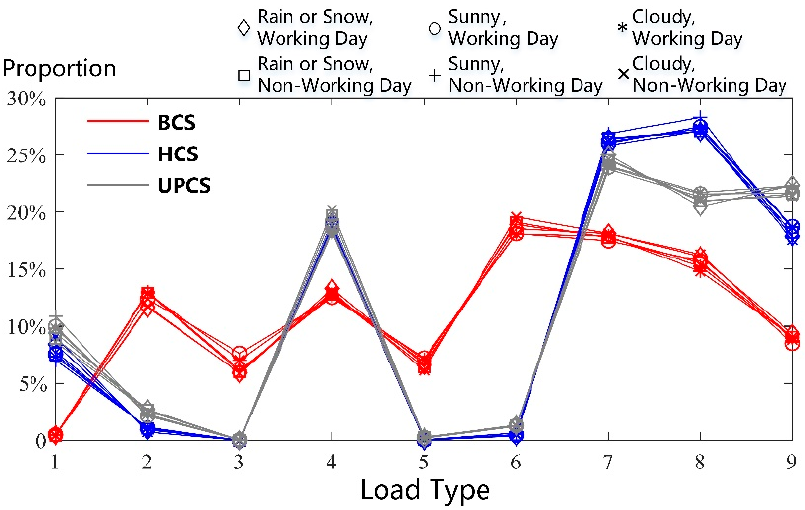
Figure 10. Proportion of each type of load in different scenarios.